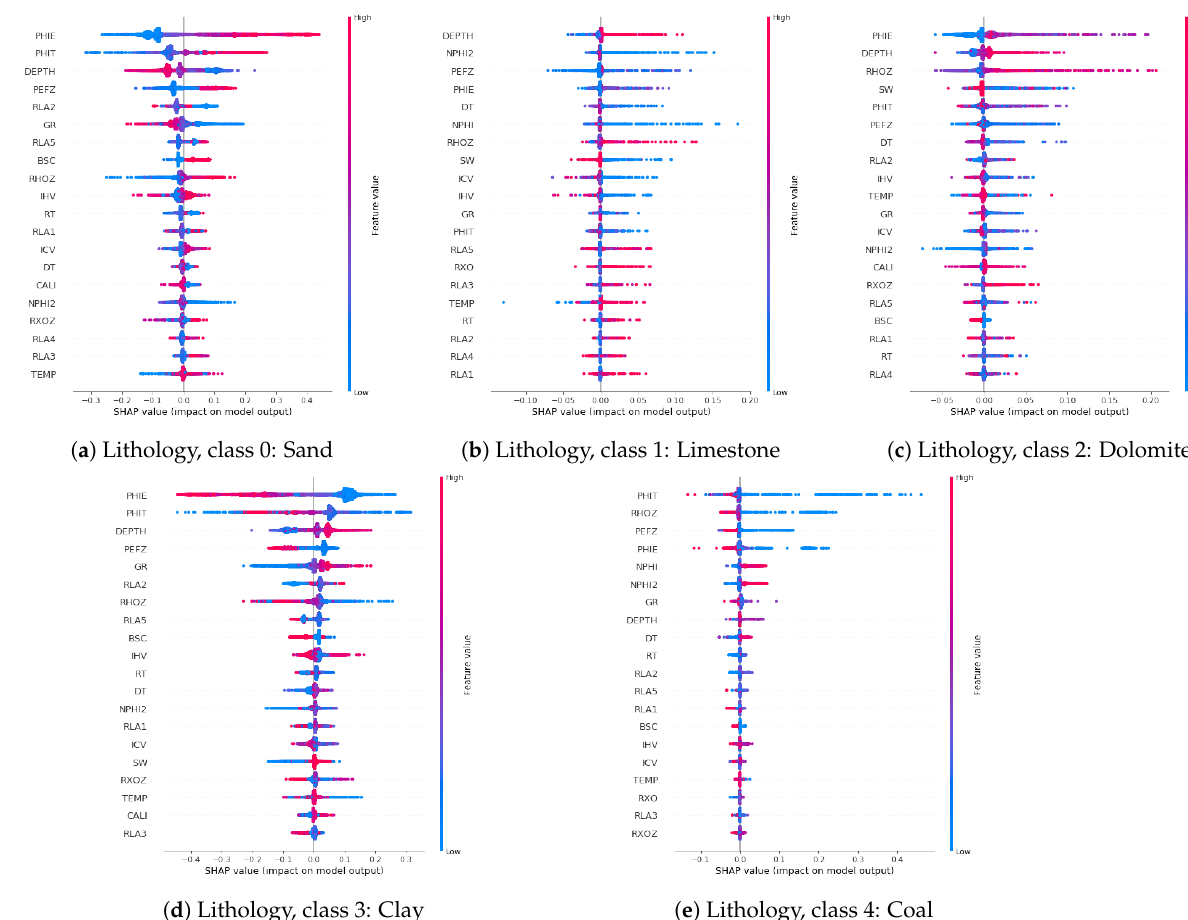
Figure 10. Summary plots for influence models prediction by classes for Kazakhstan